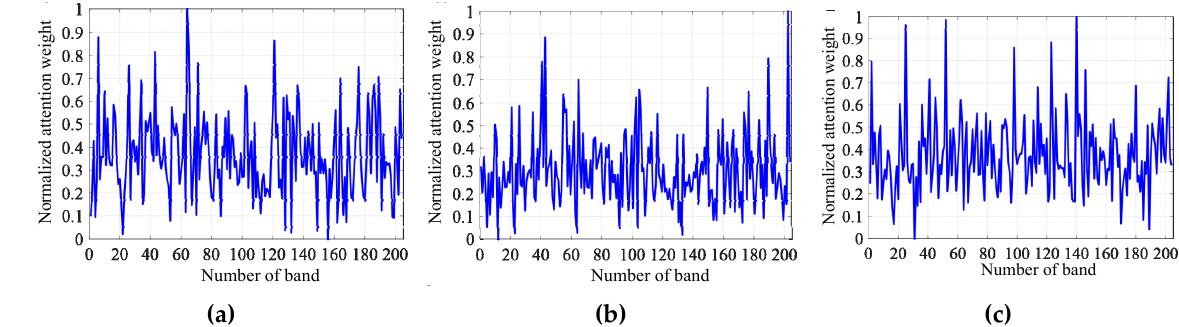
Figure 10. Visualization of attention weights for the head 2, layer 2 of T-SST on the Salinas dataset. ( a ) Dependency relations between the band 1 and another band; ( b ) dependency relations between the band 100 and another band; ( c ) dependency relations between the band 204 and another band.